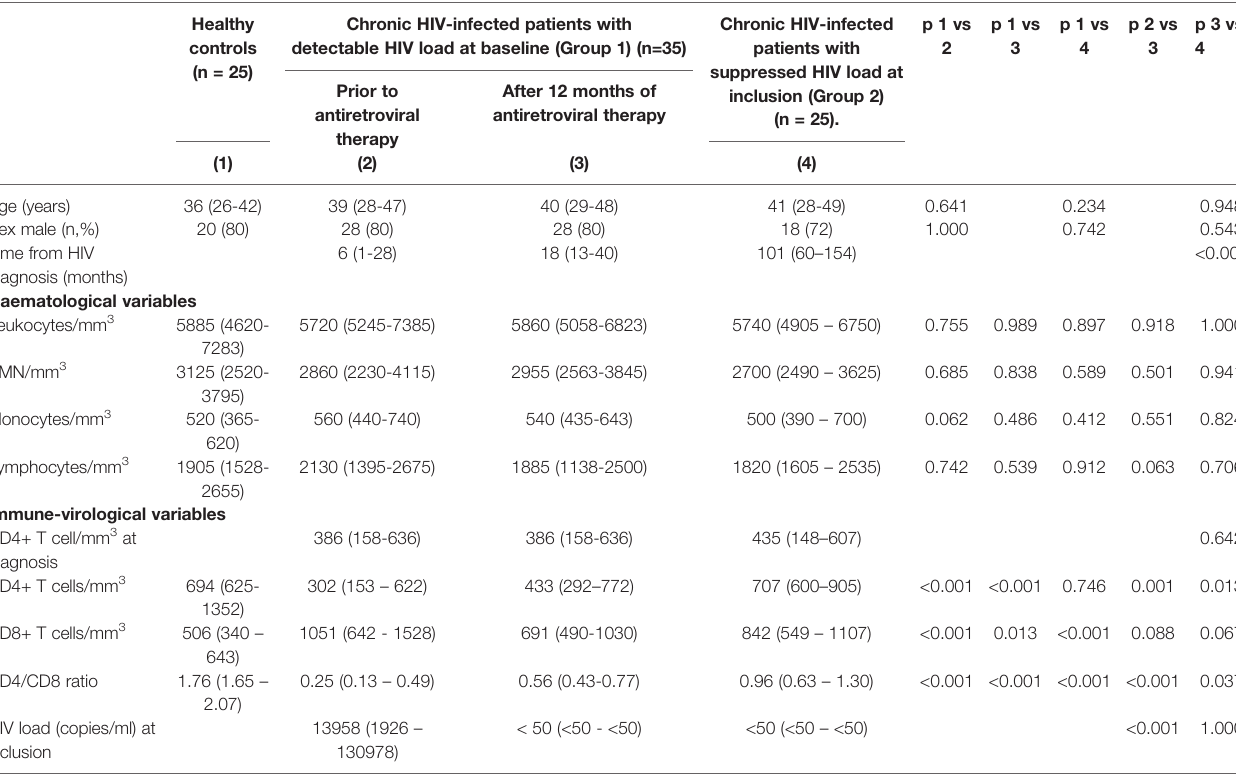
TABLE 1 | Hematological, immune and virological characteristics and gut barrier lesion and bacterial translocation markers of healthy controls and HIV-infected patients. Healthy